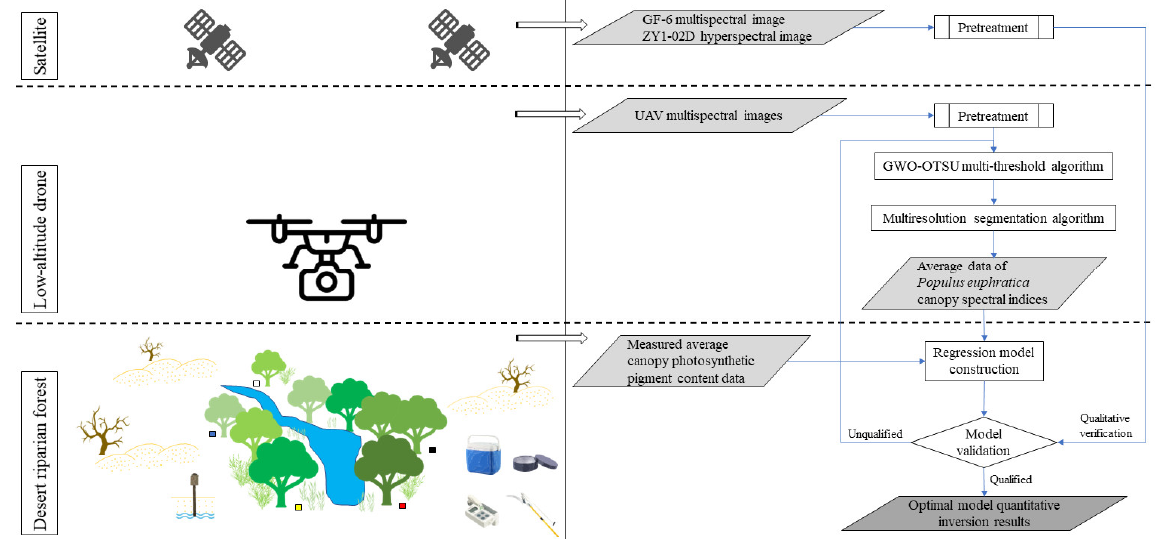
Figure 1. Schematic diagram of this study.